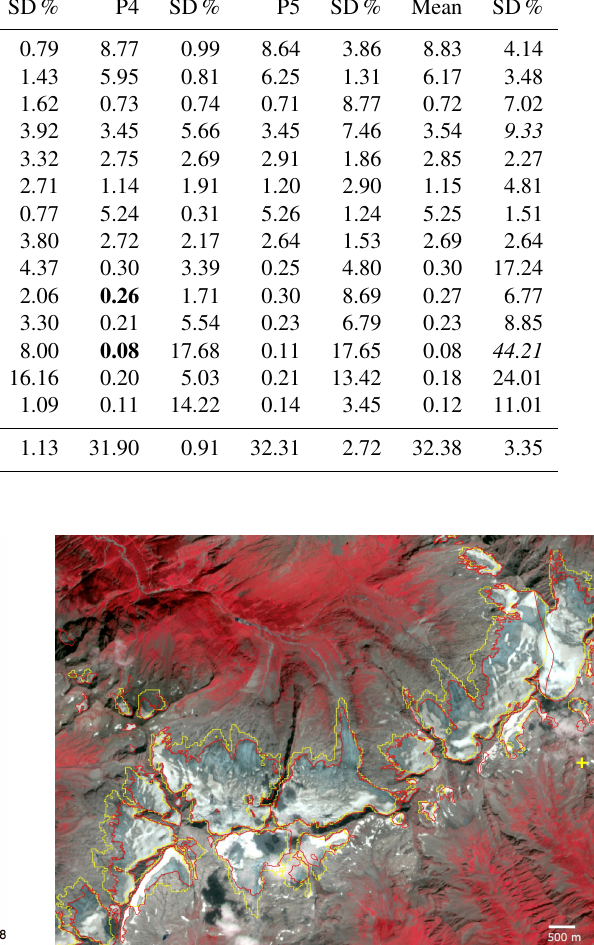
Table 3. Results of the multiple digitizing experiment, listing for each of the five participants the mean glacier area (in km 2 ) in the columns P1 to P5, along with the standard deviation in percent (SD%). The last two columns provide the averaged values across all participants for each glacier and the last row gives total areas and their standard deviation across all glaciers and for each participant. The two values marked in bold are mean values derived from the other four participants. In the last column, values in italic mark highest values for glaciers larger and smaller than 1km 2 . Glacier ID 4 is missing as it was digitized as one glacier (with ID 5) by most participants. Gl. ID